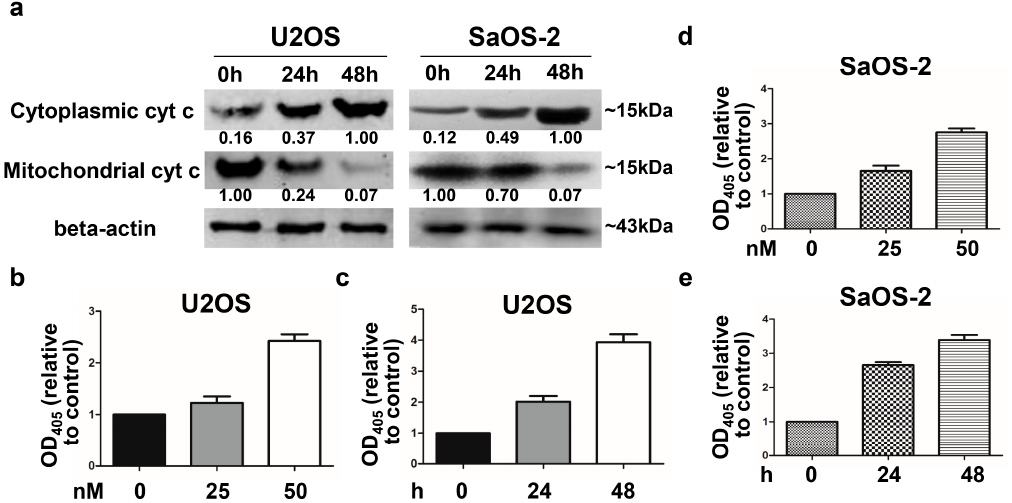
Figure 4. ( a ) Protein expression of cytoplasmic and mitochondrial cytochrome c detected by western blot and the numbers below every picture represent semi-quantitative analysis of each line; ( b , c ) Relative OD 405 value of U2OS cells treated with different concentrations ( b ) and different time points ( c ) of oleandrin, relative to the corresponding controls; n = 3, Mean ± SEM; and ( d , e ) Relative OD 405 value of SaOS-2 cells treated with different concentrations ( d ) and different time points ( e ) of oleandrin, relative to the corresponding controls; n = 3, Mean ± SEM.